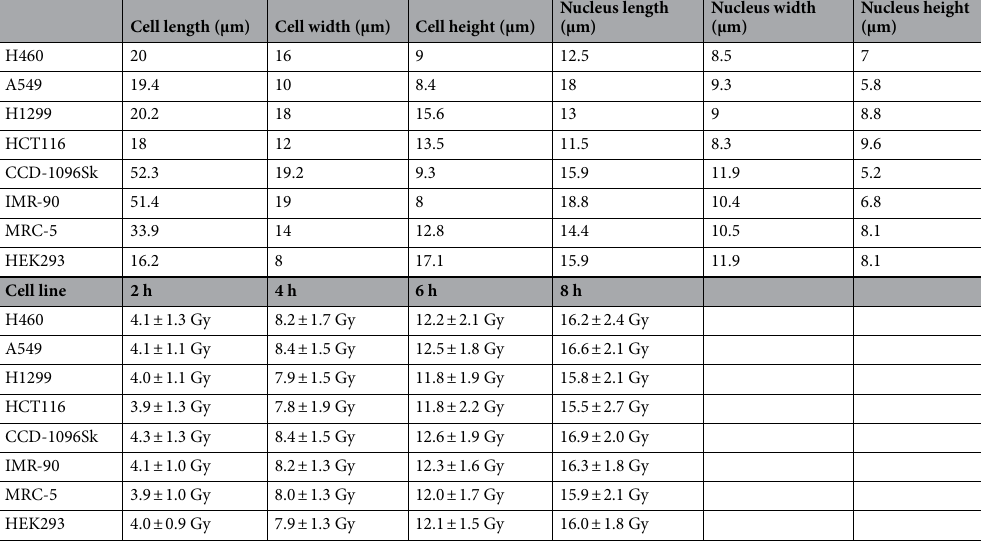
Table 1. Cell size and absorbed